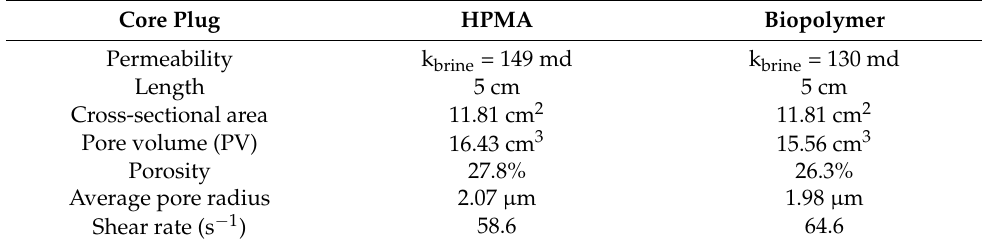
Table 2. Plug Parameters of Core Flood